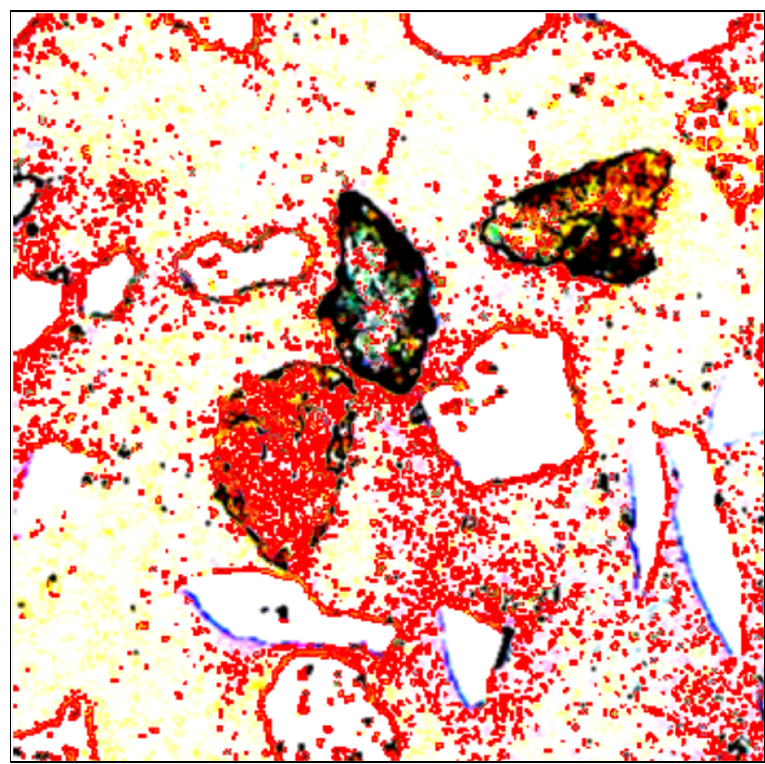
Figure 8. Thresholding of non-opaque particle by “Threshold bulk” (red—thresholded phase, for original image see Figure 2).